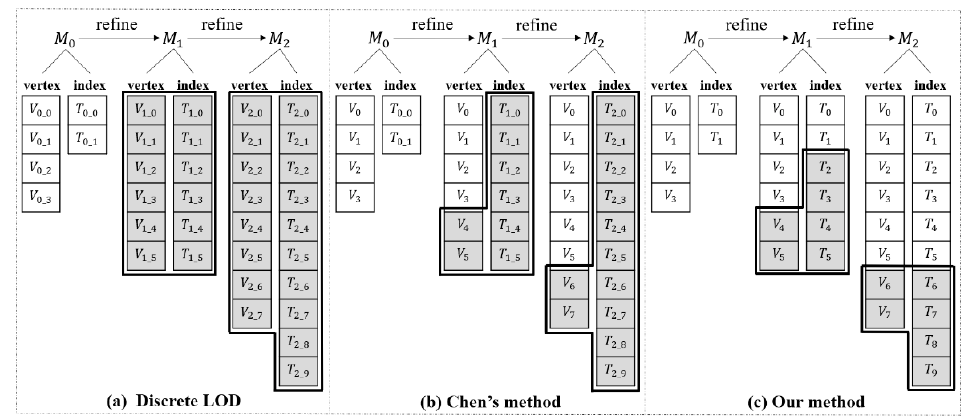
Figure 1. Comparison of data transmitted by three methods when refining the model: ( a ) Discrete LOD; ( b ) Chen’s method; ( c ) Our method.